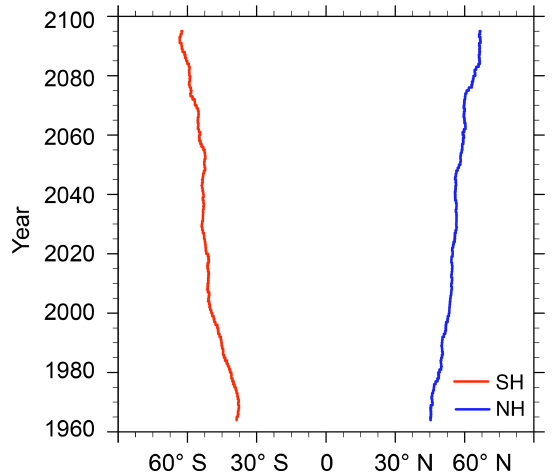
Figure 7. Time evolution of the meridional position of the zonal mean AoA = 2 years isoline at 20gpkm after the correction to the upward shift of pressure levels for CMAM. The evolution is smoothed by a decadal running